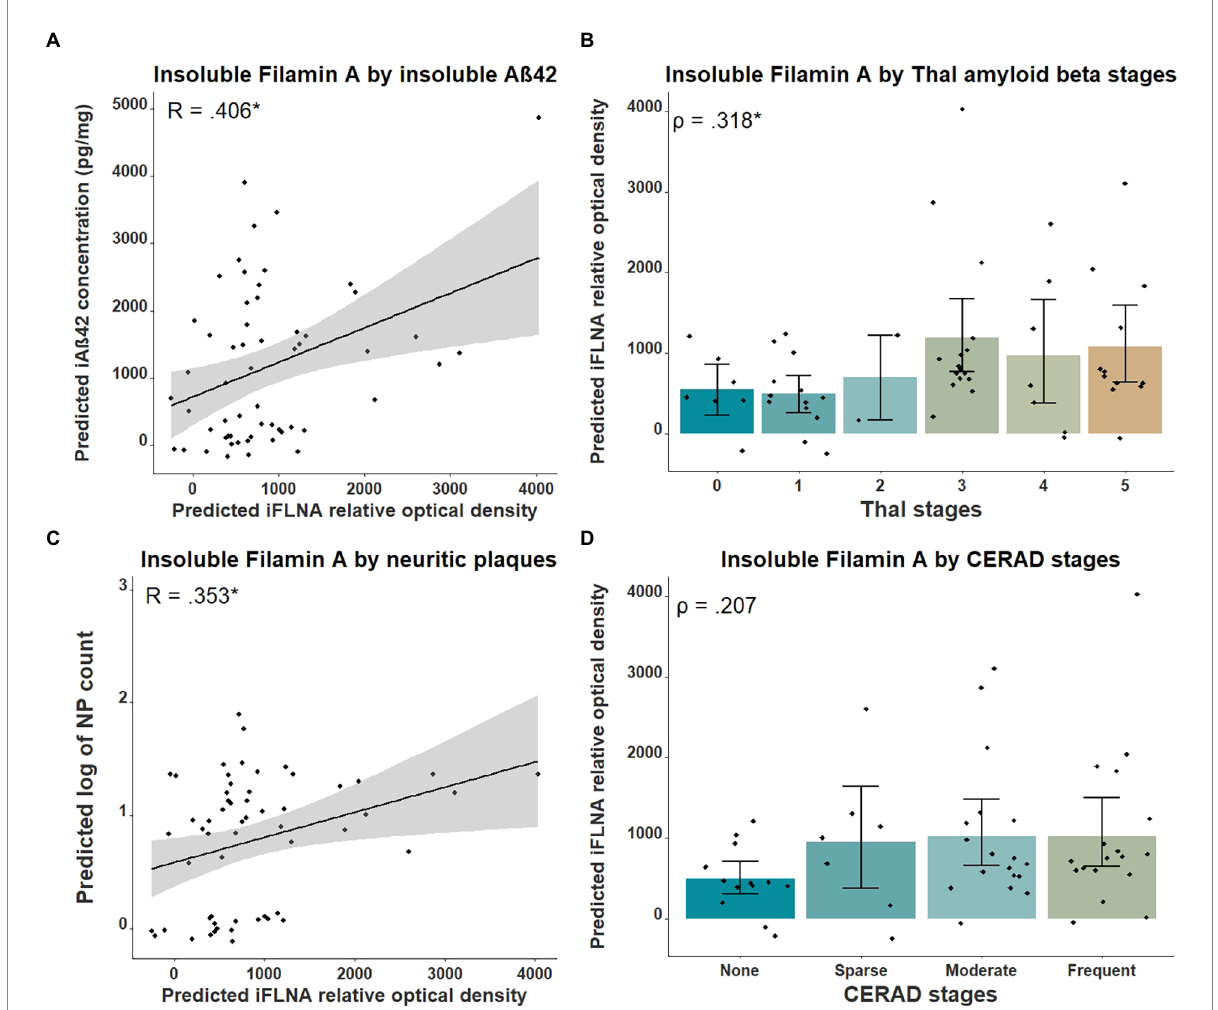
FIGURE 2 Associations between insoluble FLNA and A β -derived metrics. Insoluble FLNA (iFLNA) levels are significantly associated with insoluble A β 42 [iA β 42 ; (A) ], Thal stages (B) and neuritic plaques (NP) (C) . However, the association with CERAD stages is not significant (D) . Predicted insoluble FLNA, A β 42 and NP values shown were calculated by adding the mean to the residual values from age, sex and study batch linear regression. Standardized beta and rho values are used to display the strength of associations. *: p < 0.05.